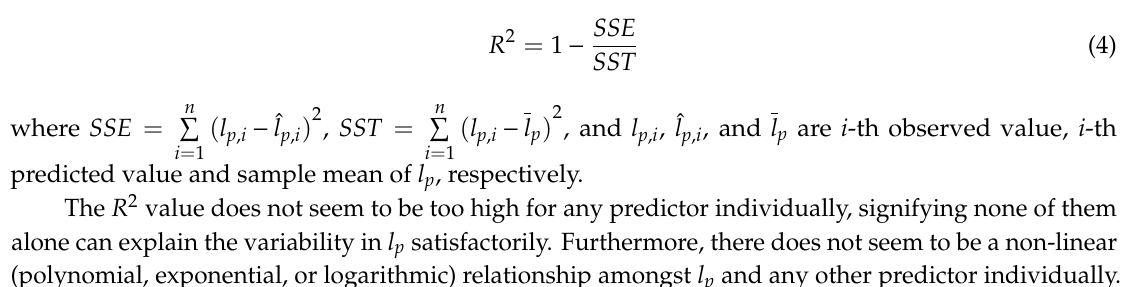
Figure 2. Histogram of l p for ( a ) plant I, and ( b ) plant II.